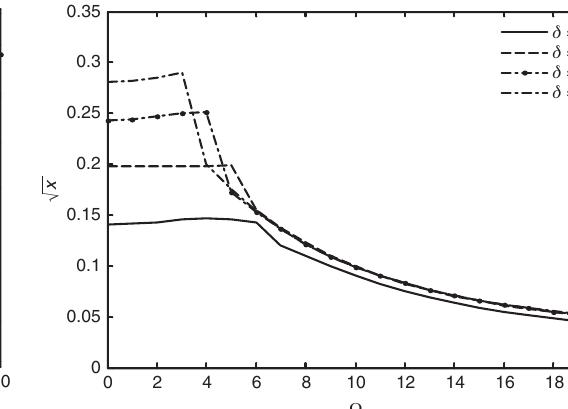
Figure 14: Variations of non-dimensional phase speed ( ) x against rotation parameter Ω